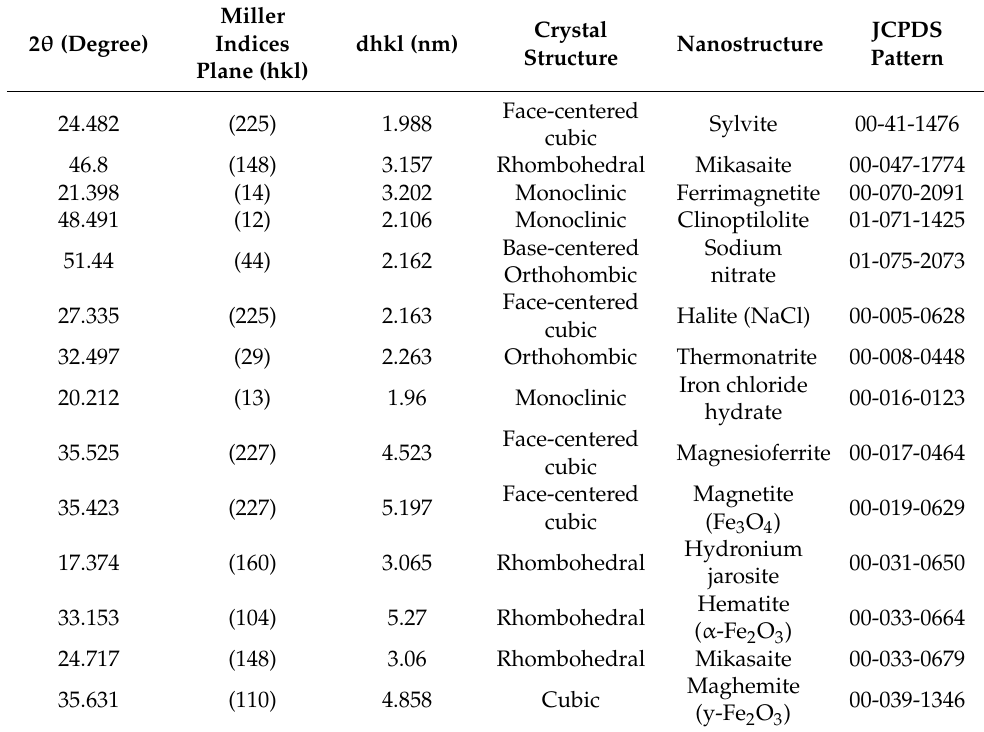
Figure 4. XRD spectra ( a ), Chitosan and its magnetized coagulants ( b ) Rice starch and its magnetized coagulants Table 6. Physical and chemical properties of the MCs characterized obtained from the XRD.